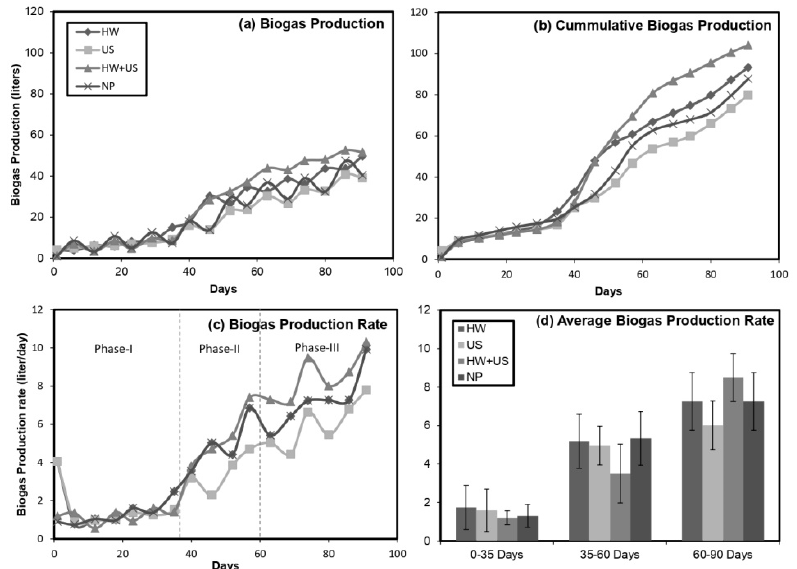
Figure 3. Biogas yield of the co-digestion of cotton gin trash with different pretreatments. Actual biogas generation: liters per sampling interval, ( a ), cumulative biogas production; liters, ( b ), biogas production; liters per day, ( c ), and average biogas production rate in three phases; liters per day, ( d ).